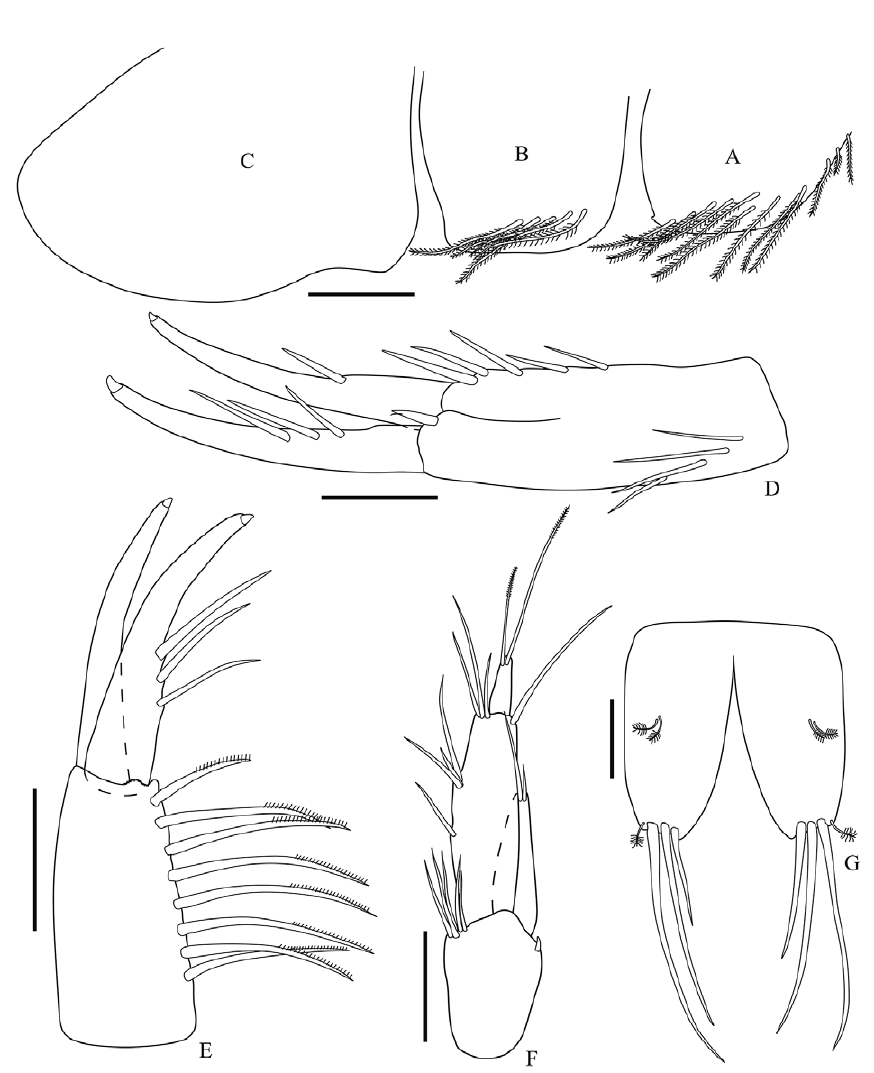
Fig. 5. – Atlantiphoxus wajapi n. sp. holotype female (UERJ 401). A, epimeral plate 1; B, epimeral plate 2; C, epimeral plate 3; D, uropod 1; E, uropod 2; F, uropod 3; G, telson. Scale bars: A-F: 0.2 mm, G: 0.1 setae, anteroventral corner rounded, posteroventral corner weakly produced into a small spine, posterior margin convex. Epimeral plate 2 (Fig. 5B) anterior and ventral margins almost straight, with facial row of 5 long plumose setae, anteroventral and posteroventral corners rounded, posterior margin convex. Epime- ral plate 3 (Fig. 5C) anterior margin weakly concave, anteroventral corner rounded, ventral margin weakly concave proximally, posteroventral corner rounded and strongly produced. Uropod 1 (Fig. 5D) peduncle 2.9× longer than wide, with 4 basofacial setae proxi- mally, dorsolateral corner with 1 stout setae, dorsome- dial margin with 5 setae; outer ramus dorsal margin with 3 stout setae, bearing 1 apical nail; inner ramus subequal to outer, dorsal margin with 1 stout seta, bear- ing apical nail. Uropod 2 (Fig. 5E) peduncle 2× longer than wide, dorsolateral corner weakly projected and laterally combed distally, dorsomedial margin with 8 long stout pectinate setae; outer ramus dorsal margin with 3 stout setae, bearing 1 apical nail; inner ramus